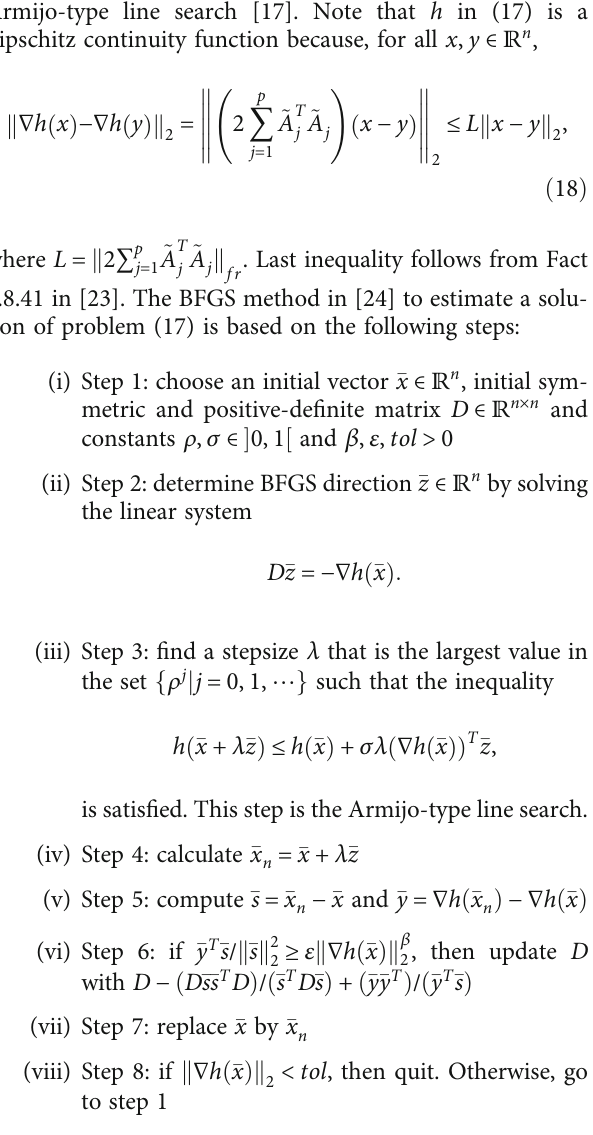
algorithm uses a generalized low-rank matrix approximation problem to estimate rank-constrained